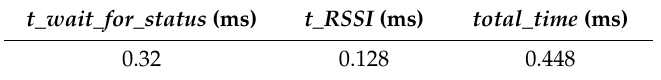
Table 6. E ff ective time factors per idle listening based on RSSI under Cooja simulator